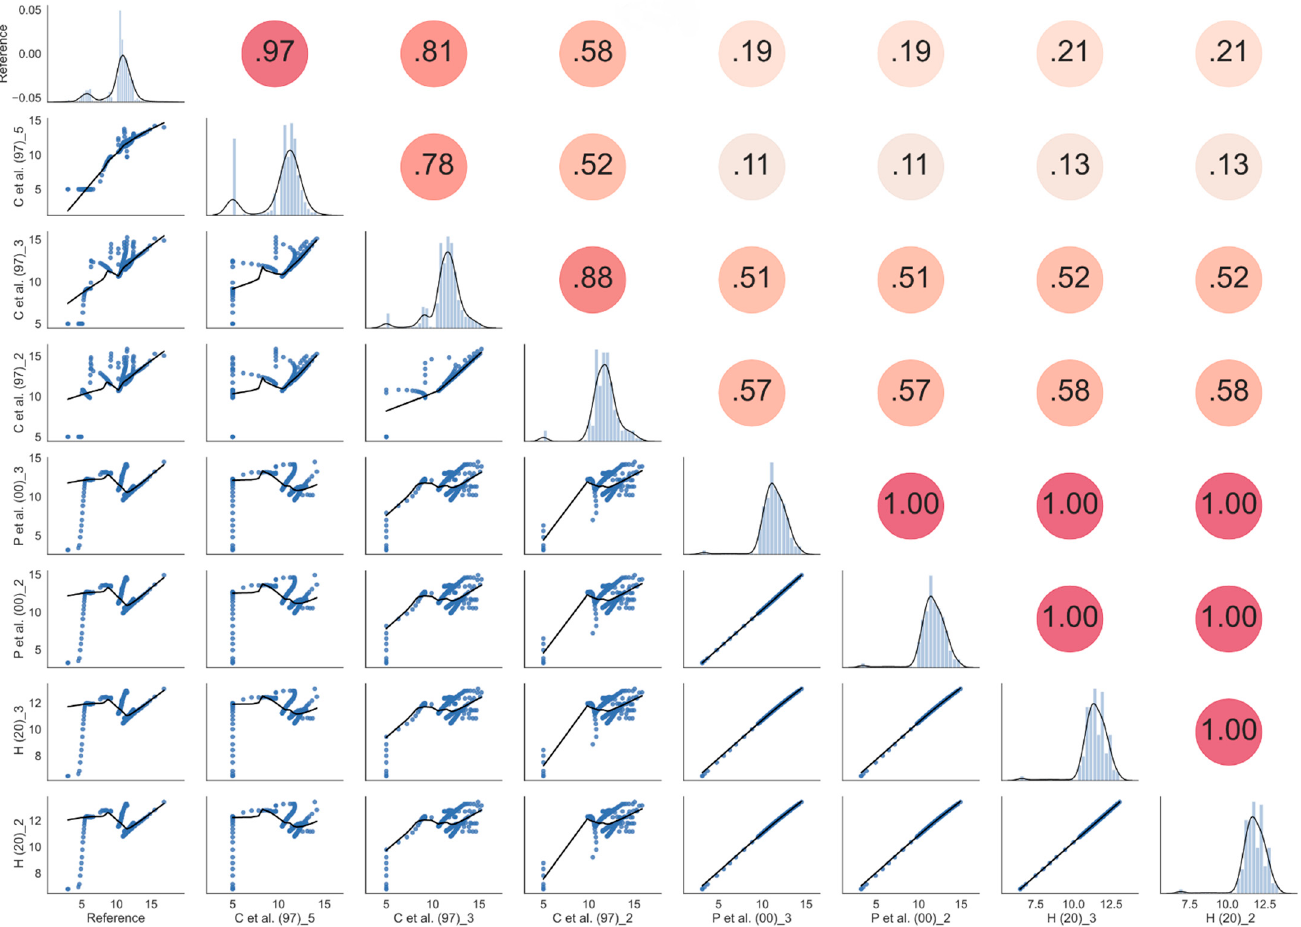
Figure 23. Statistical analysis with scattering plots, cross-correlation values, and kernel density estimation (KDE) in Loamy Sand.